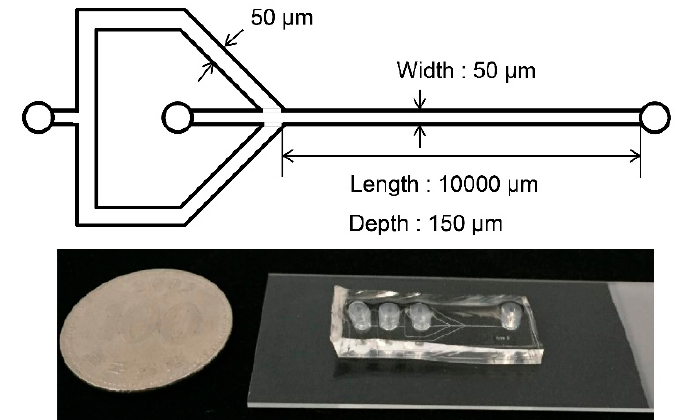
Figure 14. Picture of the fabricated device with detailed dimensions.